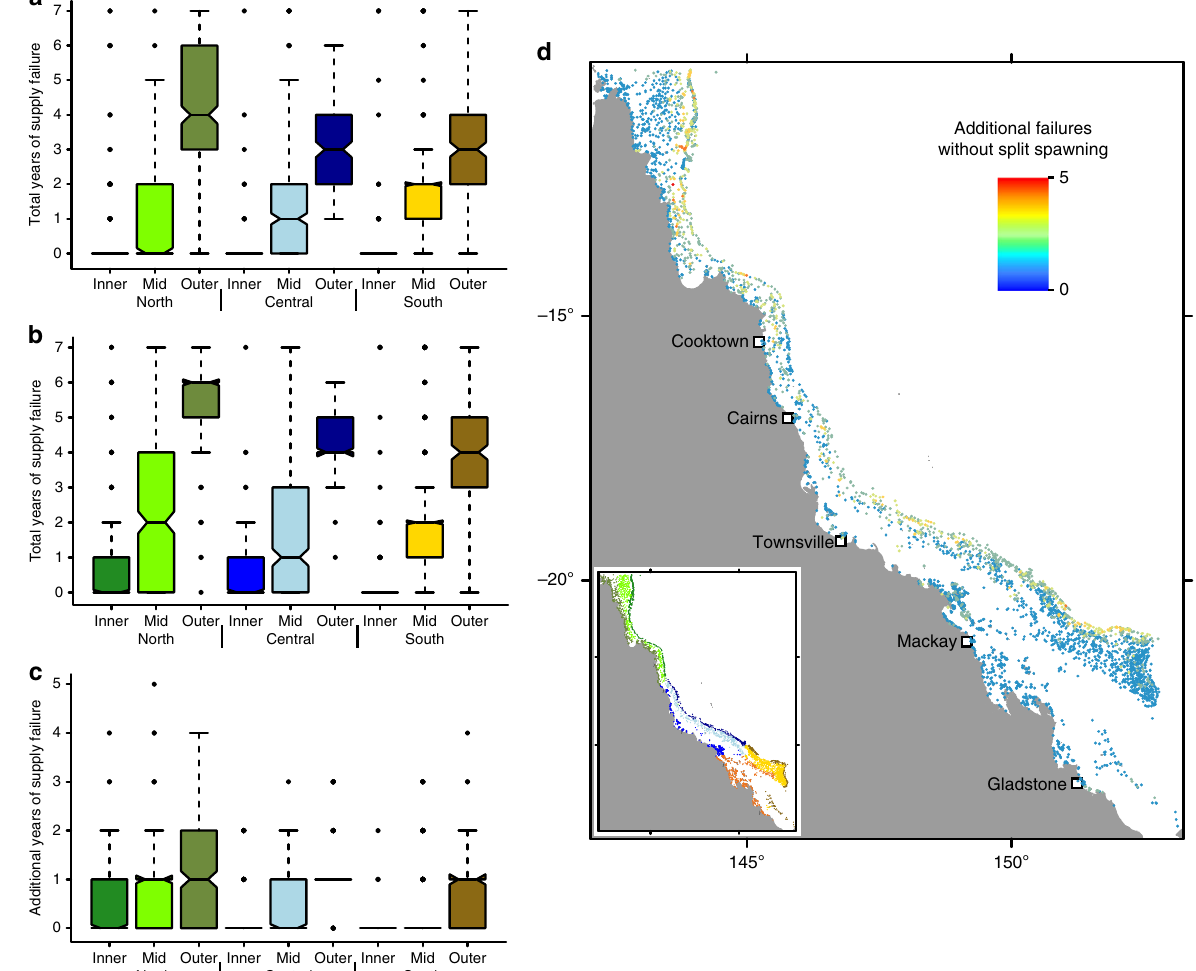
Fig. 4 Effects of split spawning on reliability of larval supply from external sources. Number of years with external supply failure observed in the models ( a ) with, and ( b ) without, split spawning for reefs across sectors. Reefs with fewer supply failures would tend to have more reliable supply of coral larvae from external sources. ( c ) Additional years of supply failure the reefs would experience without split spawning. ( d ) Map showing locations of reefs that would experience more supply failure events if coral populations on the GBR did not undergo split spawning. The maximum number of years in all analyses was 7. The colours of the boxes in ( a ), ( b ), and ( c ) correspond to the colour scheme of the GBR sectors shown in the inset in ( d ). In boxplots, the centre line represents the median, the upper and lower limits of the box represent the third and fi rst quartile respectively, the notches in the boxes represent the con fi dence interval around the median (equal to ±1.58 times interquartile range divided by square root of the sample size), the whiskers extend up to 1.5 times the interquartile range from the bounds of the box, and the points represent outliers beyond the limits of the whiskers. In ( d ) blue hues show reefs that would not have additional years of supply failure without split spawning, and red hues show the reefs that would have up to 5 additional years